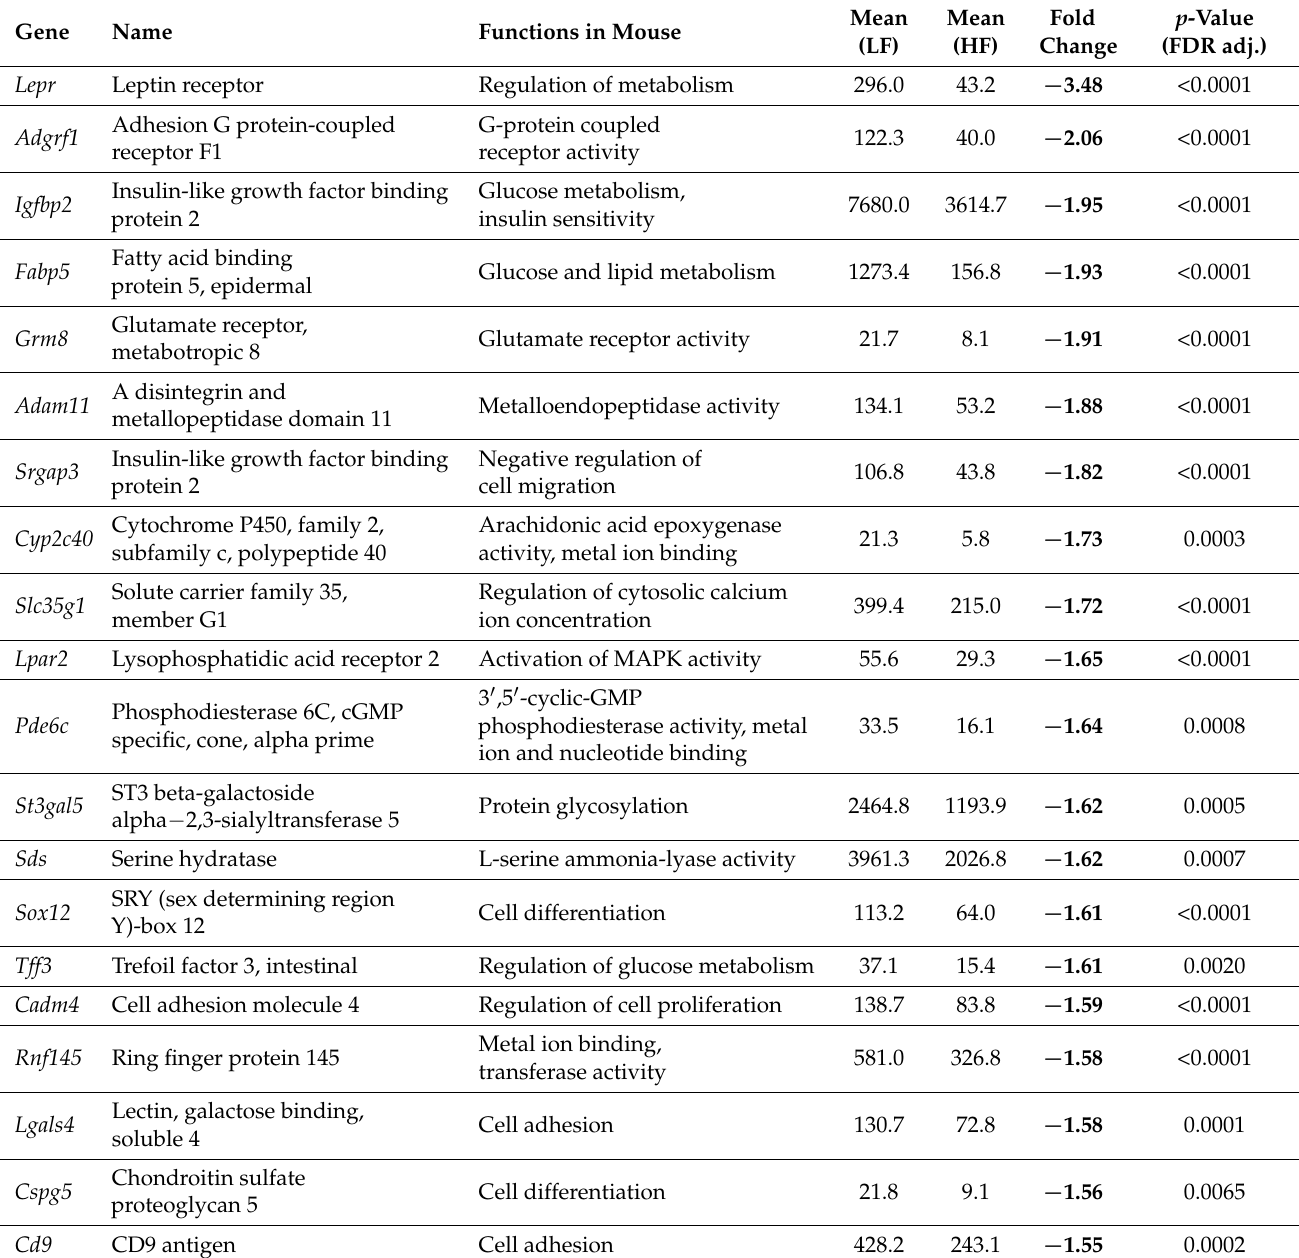
Table 2. The twenty most strongly downregulated genes in the high-fat (HF) diet relative to the low-fat (LF) control. Mean expression levels are given as DESeq2-normalized counts. p -values are adjusted by false discovery rate